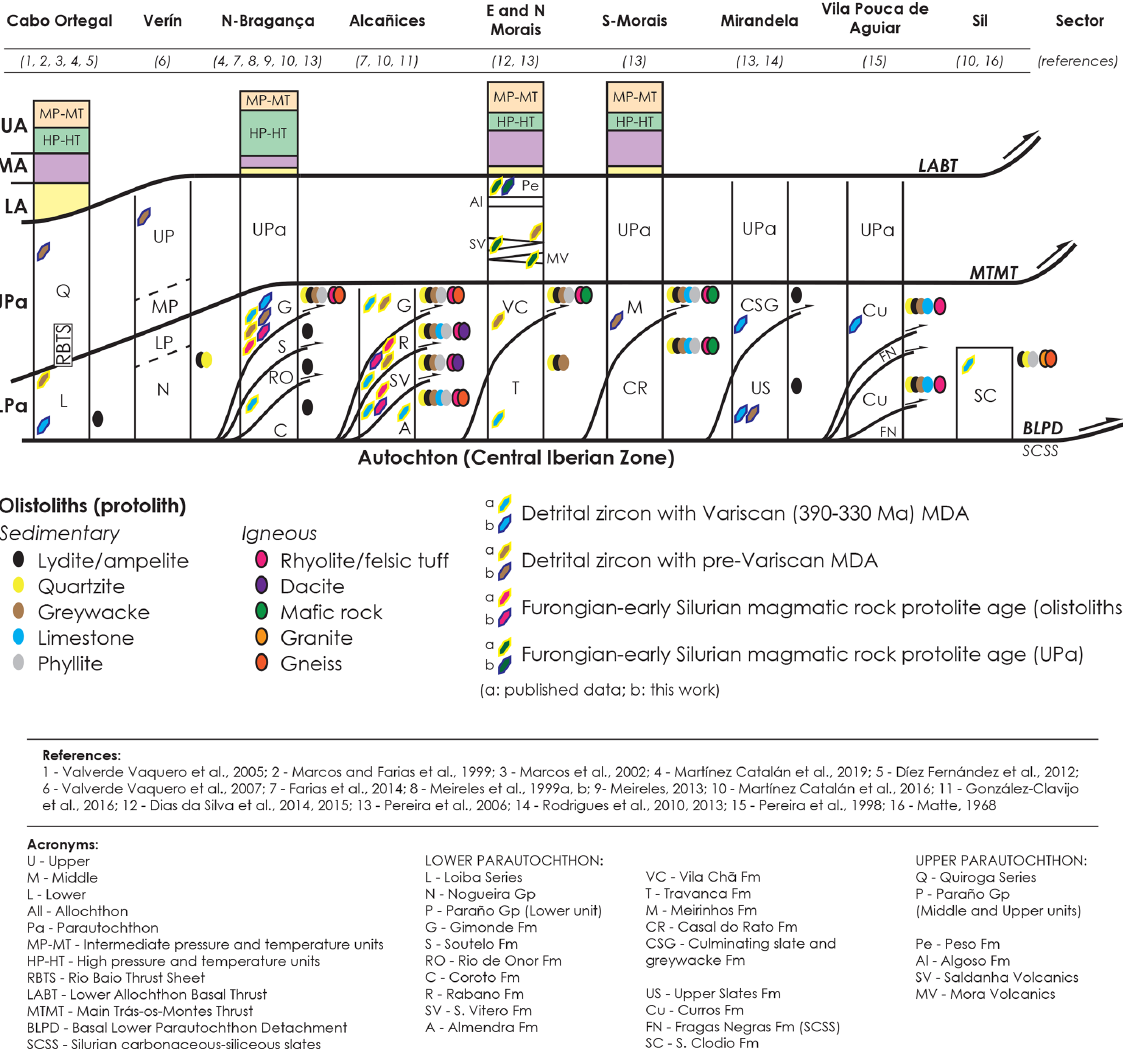
Figure 4. Regional correlation of the NW Iberian LPa stratigraphic units, and their structural relationship with the tectonically overlying (UPa and allocthonous units) and underlying geologic domains (autochthon, CIZ). See Fig. 5 for more